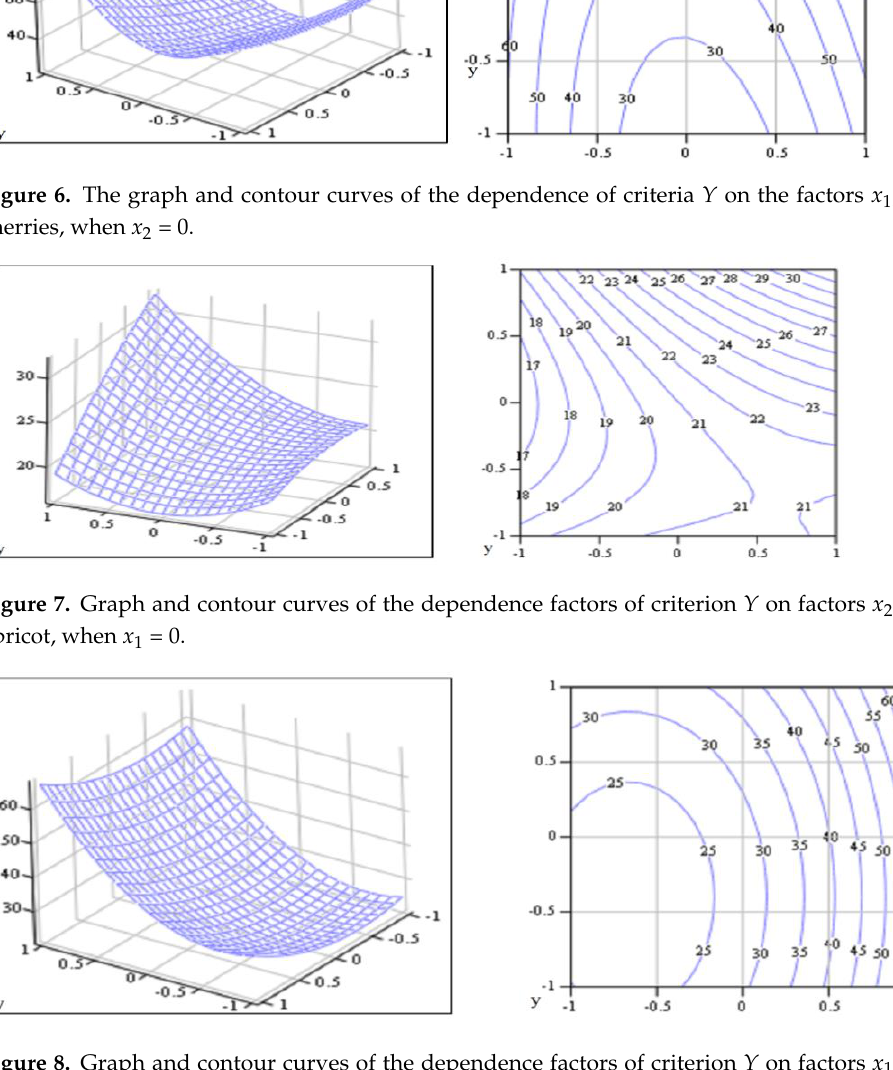
Figure 8. Graph and contour curves of the dependence factors of criterion Y on factors х 1 , х 2 for almonds, when х 3 = 0.